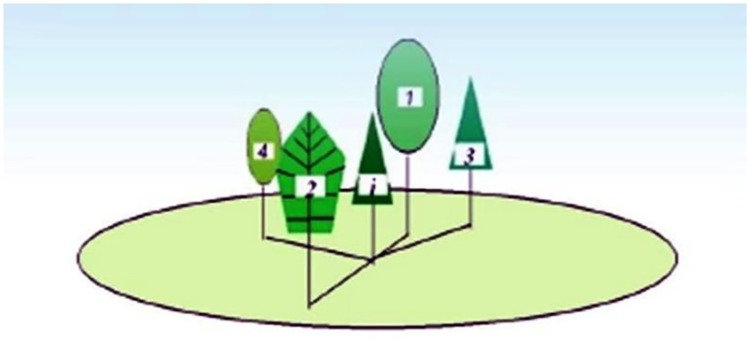
The structural unit.